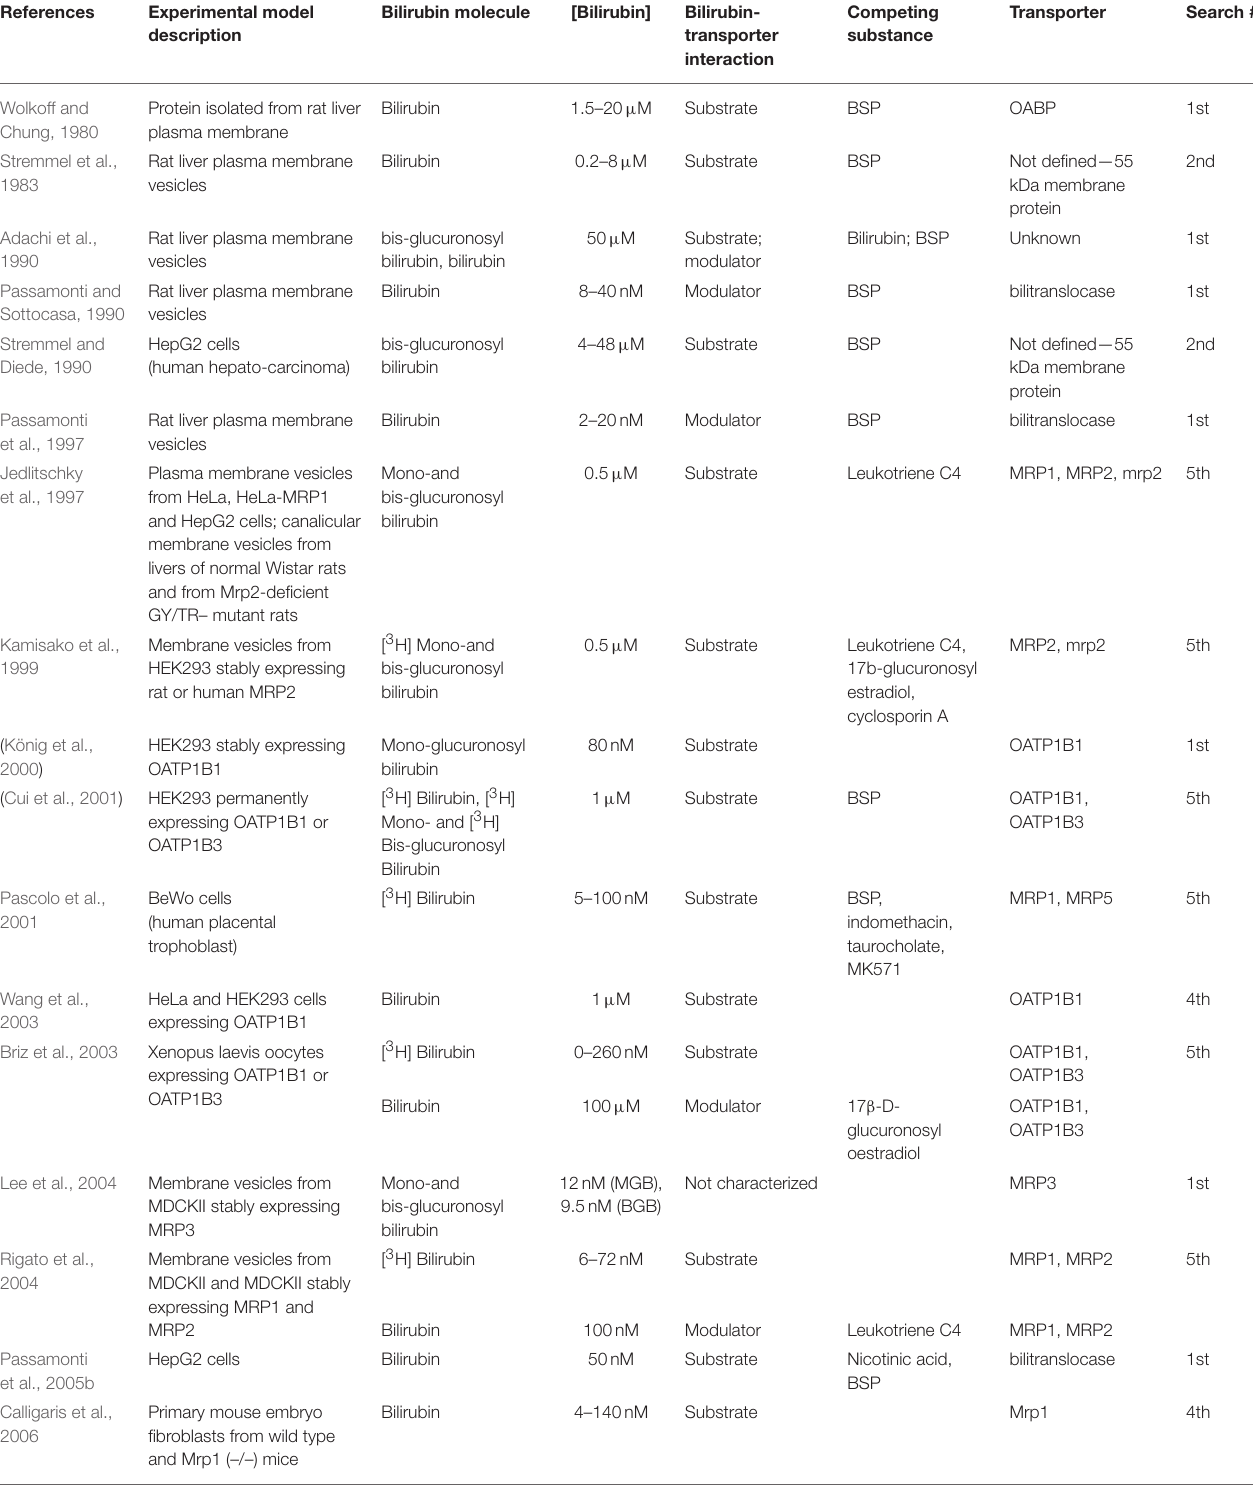
TABLE 3 | Features of included articles reporting in vitro